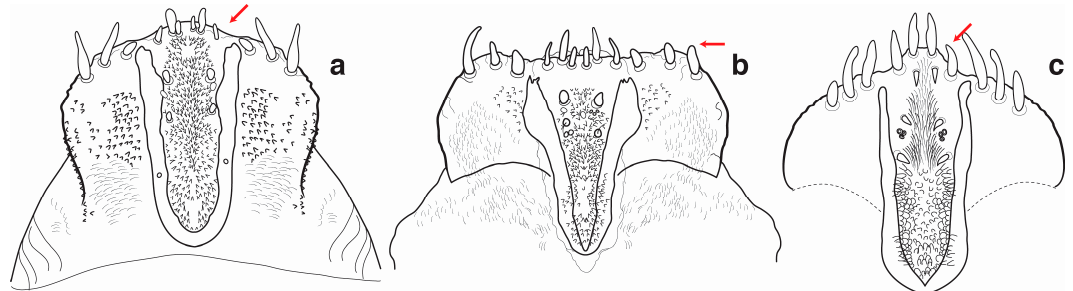
Figure 17. Epipharynx, larva: ( a ) Phacecorynes ; ( b ) Rhodobaenus; and ( c ) Polytus .